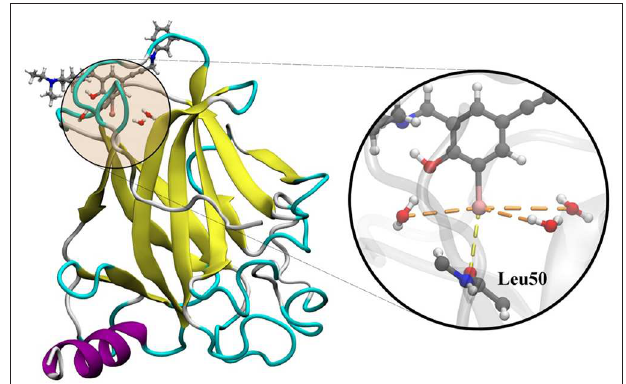
FIGURE 1 | Crystal structure of the Y220C mutant of the p53 core domain bound to a stabilized small molecule PhiKan5196 (PDB ID: 4AGQ), in which the protein is shown as its secondary structure and the ligand is illustrated by the ball-and-stick model. The major interactions of P96 with Leu50 and three water molecules are